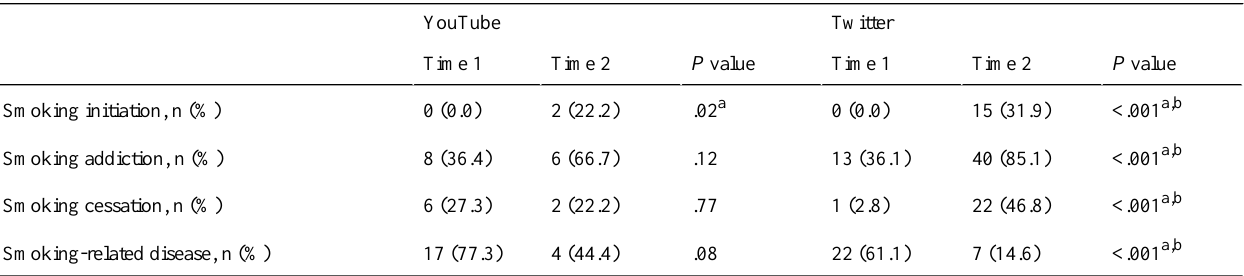
Table 2. Comparison of the posts’content between Time 1 and 2 ( P values from Pearson chi-square).